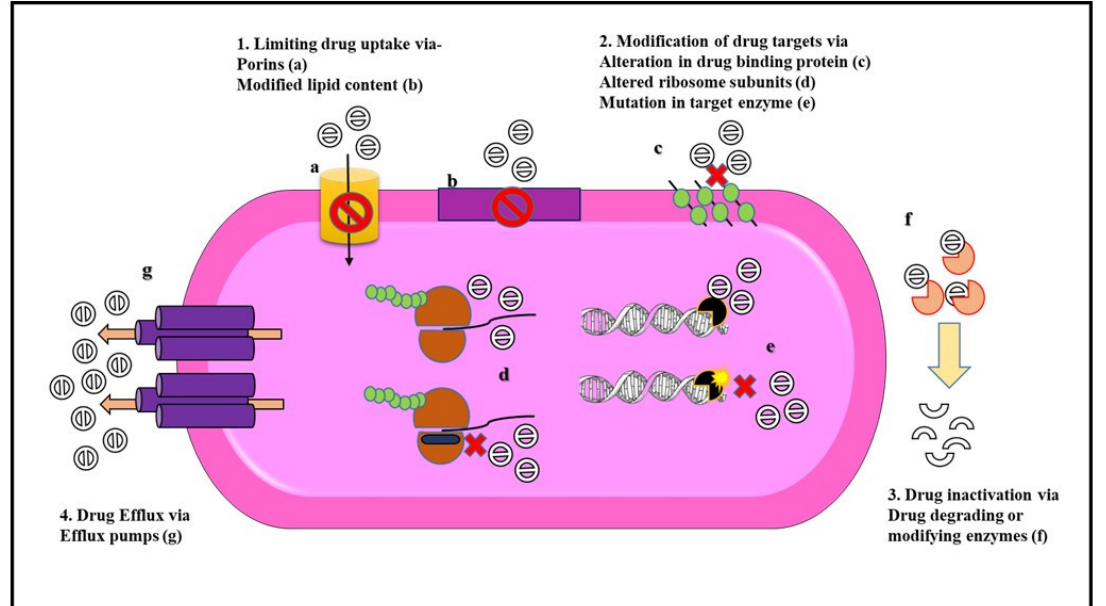
Figure 2. Mechanisms of antibiotic resistance in Gram-negative bacteria. Gram-negative bacteria exhibit different modes of resistance to overcome the action of antibiotics either due to chromosomal mutation or by the acquisition of mobile genetic elements. Some of these resistance mechanisms include ( 1 ) Limiting drug uptake with the help of ( a ) porins channel that prevents the entry of drug molecule and ( b ) modification of membrane lipid content that acts as a barrier toward the penetration of antibiotics. ( 2 ) Modification of drug targets either by ( c ) alteration in the drug-binding proteins (e.g., penicillin-binding proteins), or ( d ) altering the target ribosomal subunits (e.g., alteration in the domain V region in the 50S ribosomal subunit leads to linezolid resistance) or ( e ) by a mutation in target enzyme (e.g., mutation of DNA gyrase in fluoroquinolone resistance) which leads to a decrease in the binding affinity of the antibiotic to the target sites. ( 3 ) Drug inactivation can be either due to ( f ) the production of drug-degrading enzymes such as beta-lactamases or by drug modification via drug-modifying enzymes that conduct biochemical reactions like acetylation phosphorylation and adenylation. ( 4 ) Drug efflux is exhibited by ( g ) overexpression of efflux pumps that carry out extrusion of antibiotics from the bacterial cell (e.g., AcrAB-TolC in Enterobacteriaceae )